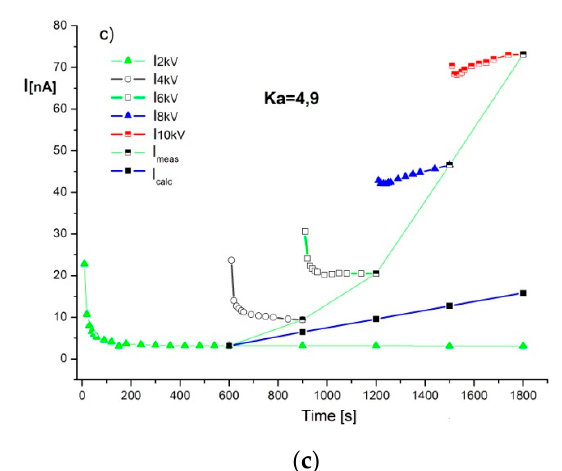
Figure 5. The SVM test chart of CRPT 52 kV bushing insulation after ( a ) 10 years of operation; ( b ) an additional 340 h of aging after deinstallation; ( c ) an additional 740 h of aging after deinstallation [16].